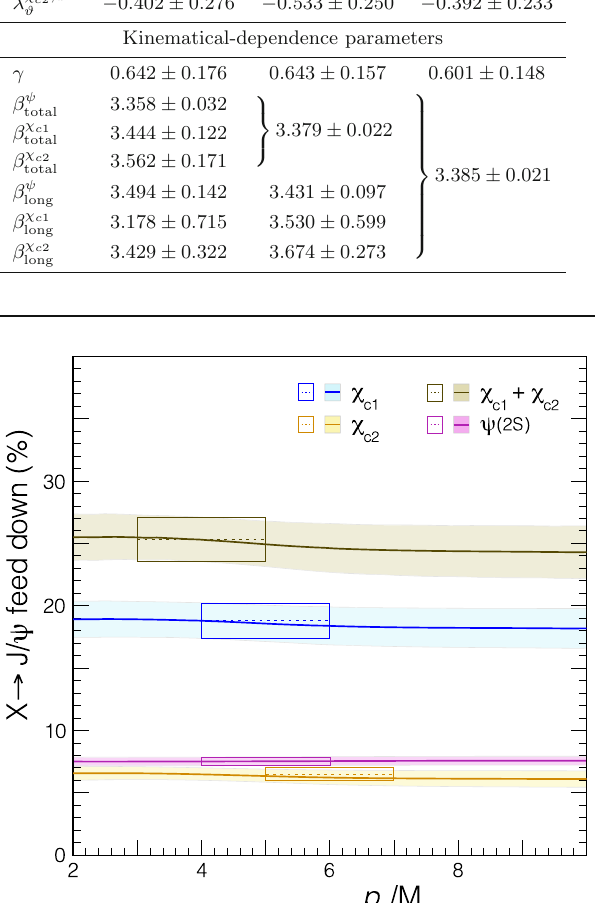
Fig. 4 The fractions of the total prompt J /ψ production rate due to feed-down decays from the χ c 1 , χ c 2 and ψ( 2S ) mesons, as a function of p T / M